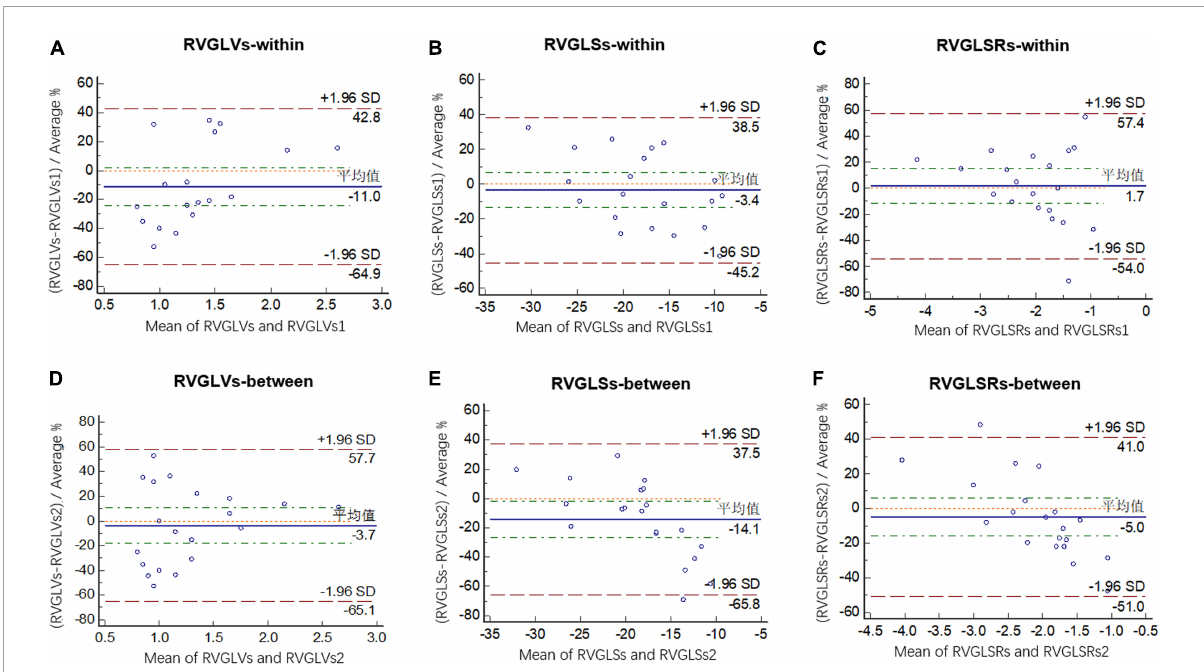
FIGURE3 Bland-Altman analysis of intraobserver variability for RVGLVs (A) , RVGLSs (B) , and RVGLSRs (C) and interobserver variability for RVGLVs (D) , RVGLSs (E) , and RVGLSRs (F) . RVGLVs, right ventricle longitudinal systolic peak velocity; RVGLSs, right ventricle global longitudinal systolic strain; RVGLSRs, right ventricle global longitudinal systolic strain rate.